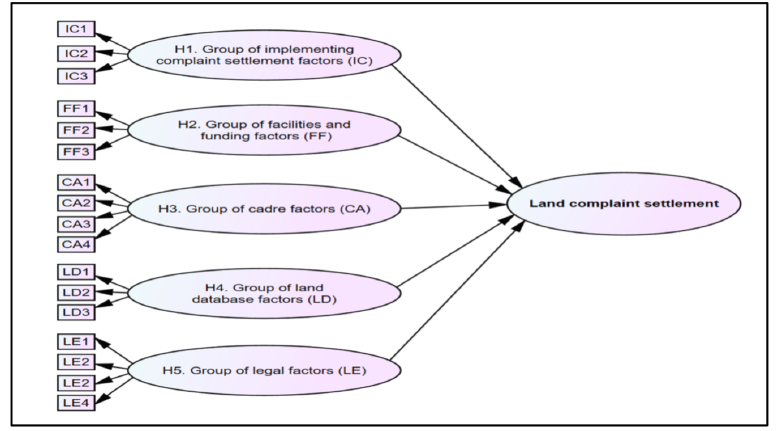
Fig. 3. Proposed research model on hypothetical factors affecting land complaint